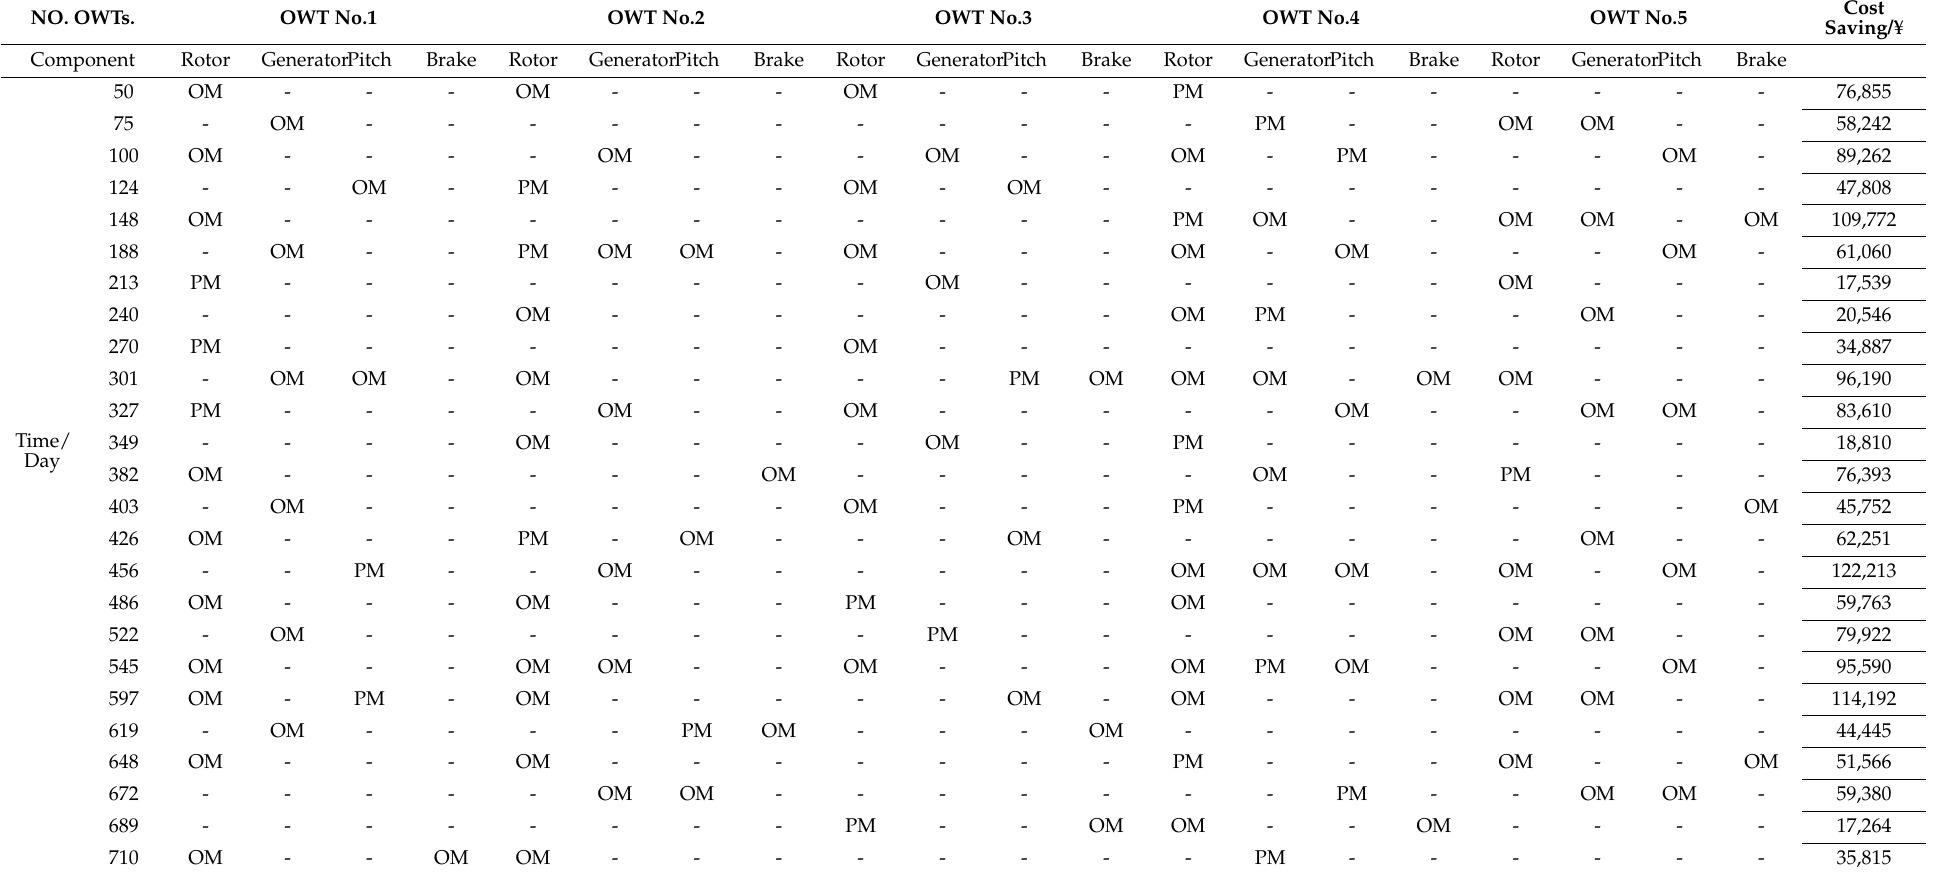
Table 6. Maintenance schedule and cost savings of five OWTs for the Dafengtian